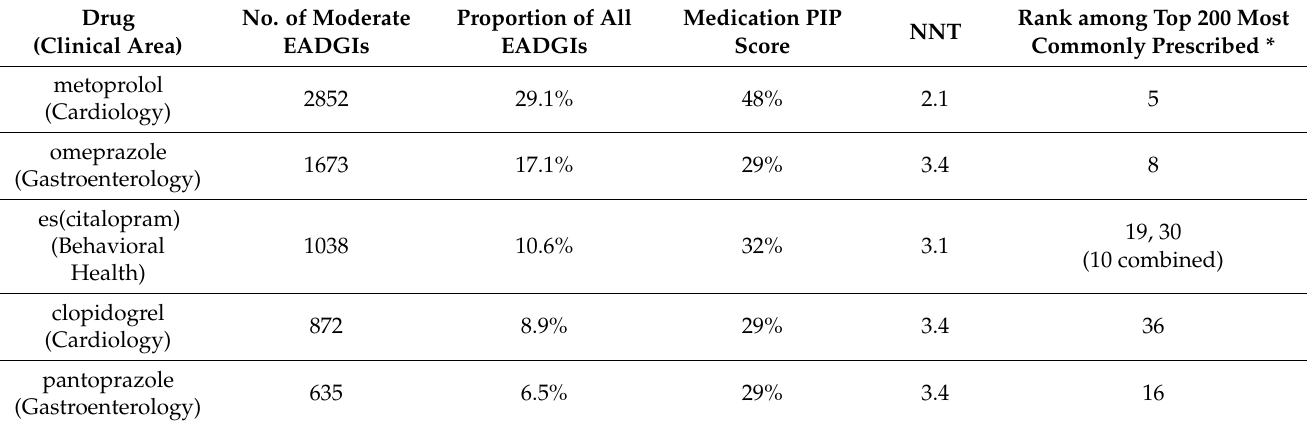
Table 5. Top five medications with EADGIs.